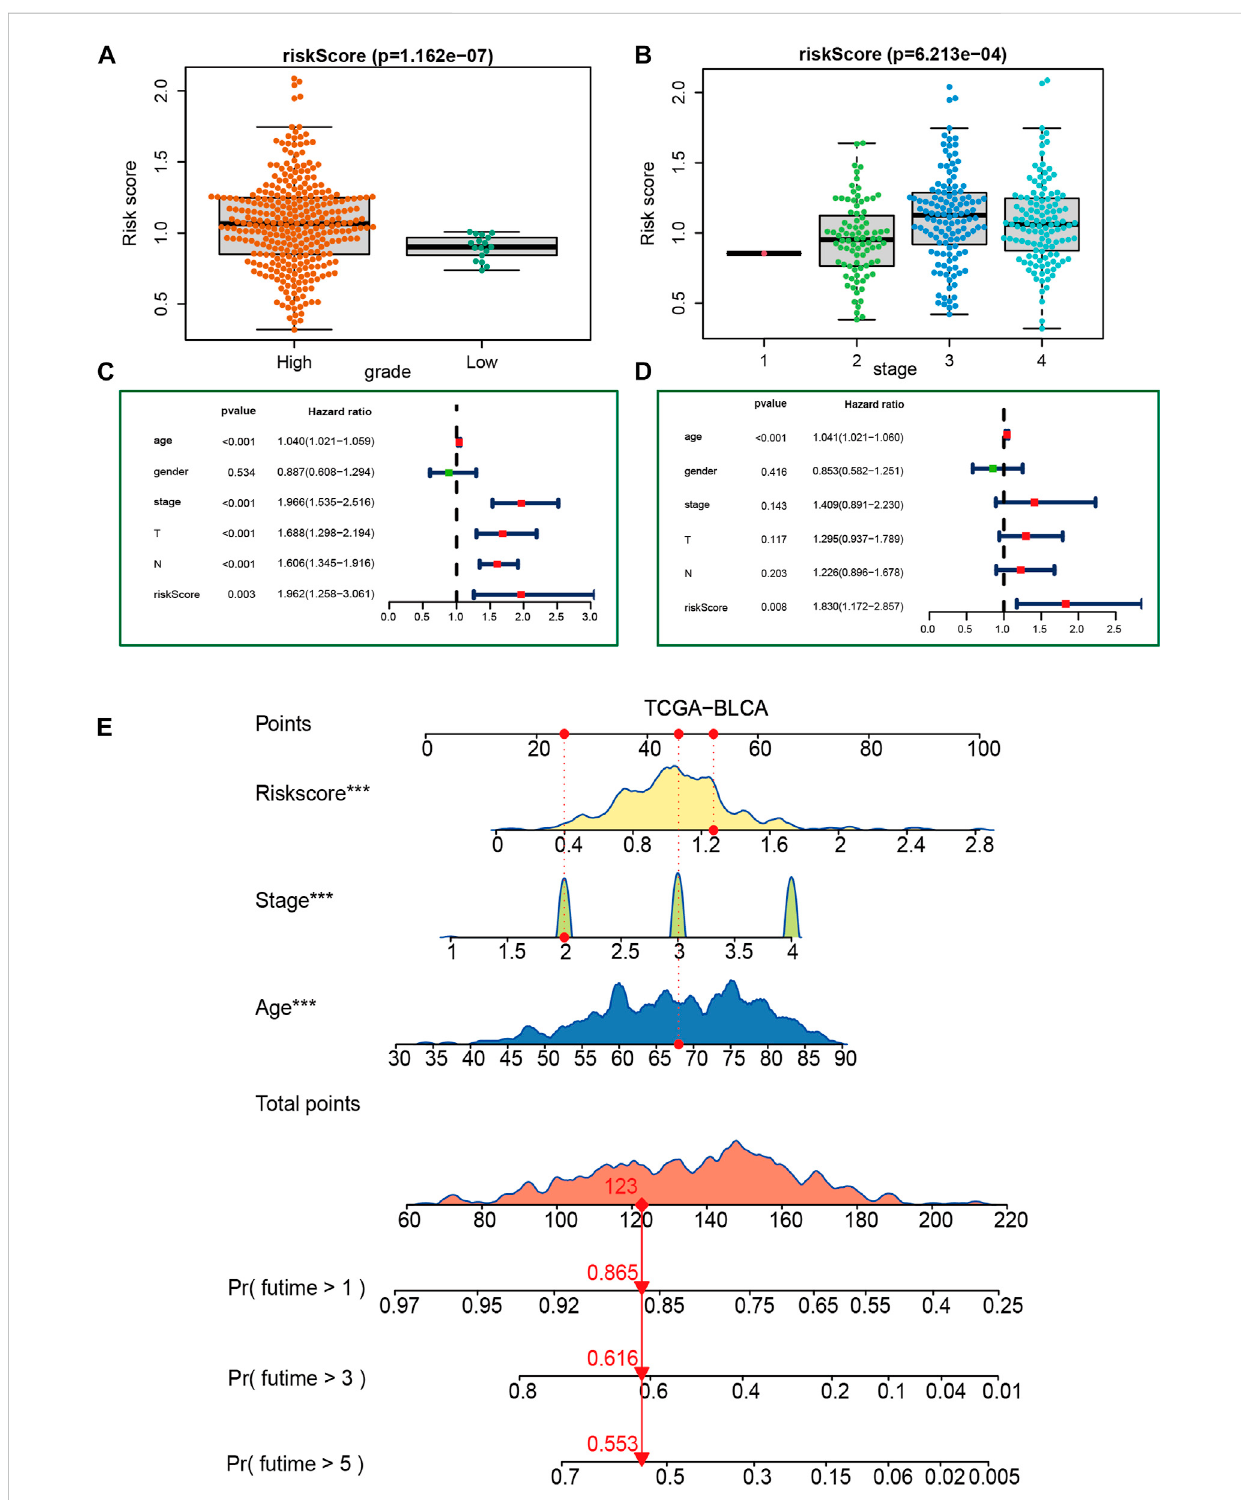
FIGURE 3 Construction of a nomogram in the TCGA-BLCA cohort. (A, B) Relationship between VM_Score and tumor grade and stage in TCGA-BLCA cohort. (C, D) Results of univariate and multivariate Cox analyses. (E) Nomogram developed based on stage, age, and VM_Score to predict overall survival at 1, 3, and 6